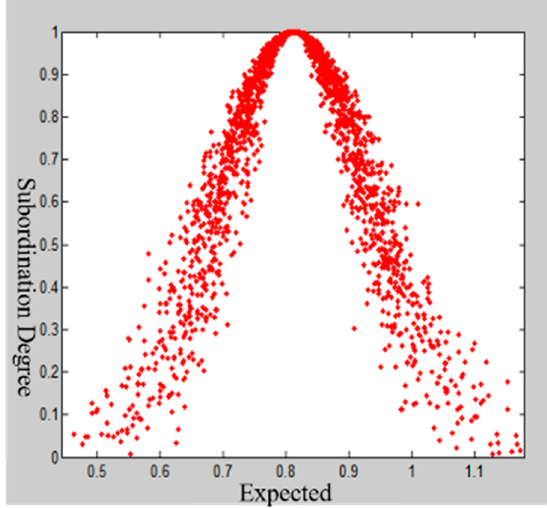
Int. J. Environ. Res. Public Health 2019 , 16 , x Figure 8. Expert scoring cloud model restoration chart for the second time. Figure 8. Expert scoring cloud model restoration chart for the second time.